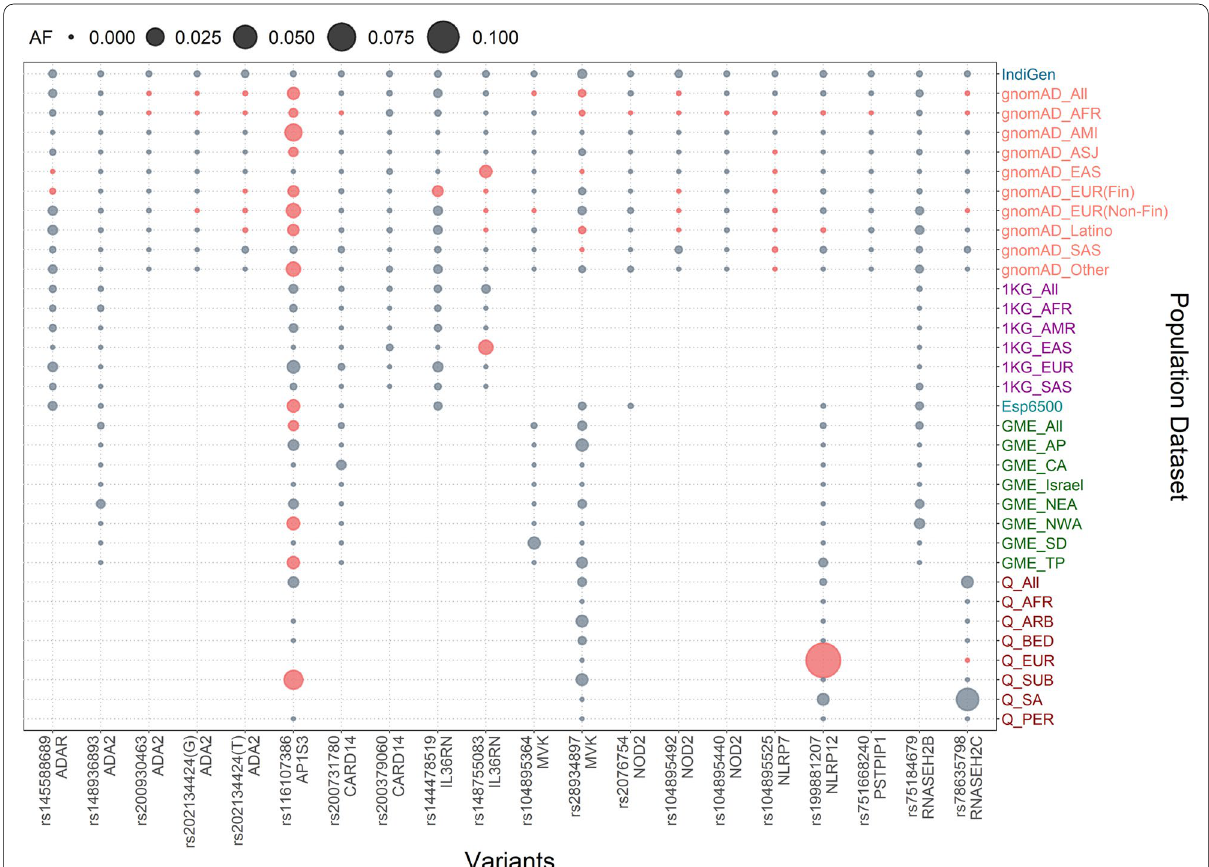
Fig. 3 Comparison of allele frequency of pathogenic and likely pathogenic variants in the IndiGen population with the gnomAD, 1000 genome project (1KG), Esp6500, Greater Middle East (GME), and Qatar (Q) and its subpopulation: Amish (AMI), European (Finnish) (EUR (Fin)),, European (Non Finnish) (EUR (Non Fin)), African (AFR), Ashkenazi Jewish (ASJ), East Asian (EAS), South Asian (SAS), American (AMR), Bedouin (BED), Sub-Saharan African (SAF), European (EUR), South Asian (SOU), African Pygmy (APY), Arab (ARA), Persian (PER), Northwest Africa (NWA), Northeast Africa (NEA), Turkish Peninsula (TP), Syrian Desert (SD), Arabian Peninsula (AP), and Persia and Pakistan (PP). CA , Central Asia. Significant allele frequency highlighted with the red